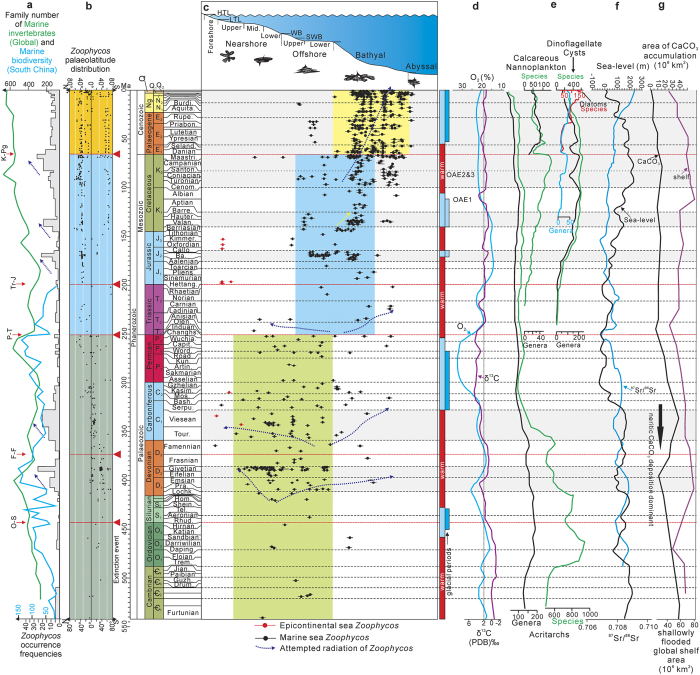
Spatiotemporal distribution of Phanerozoic Zoophycos and its bio-environmental background.(a) Curves of global family number of marine invertebrates53 and marine biodiversity from South China54. (b) Palaeolatitudinal distribution of Zoophycos. (c) Bathymetrical distribution of Zoophycos, the Zoophycos sketches redrawn from previous studies11024, the green, blue, yellow column represent the main Zoophycos distribution areas in the Palaeozoic, Mesozoic and Cenozoic, respectively. (d) Column recording climate changes and glacial periods55, curves for atmospheric oxygen38 and δ13C26. (e) Acritarchs37, calcareous nanoplankton (genera5657, species58), dinoflagellate cysts (genera5657, species59) , and diatoms (genera5657, species57) diversity curves35. (f) Curves of sea-level changes4560 and 87Sr/86Sr ratios26. (g) Curves of areas of CaCO3 accumulation and shallowly flooded global shelf area2845. Abbreviation: HTL = high-tide line, LTL = low-tide line, WB = wave base, and SWB = storm wave base. The grayish sections in the figure represent the five peaks of Phanerozoic Zoophycos.